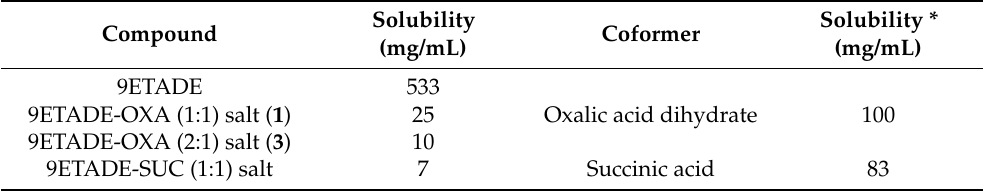
Solubility Solubility * Coformer (mg/mL) (mg/mL)